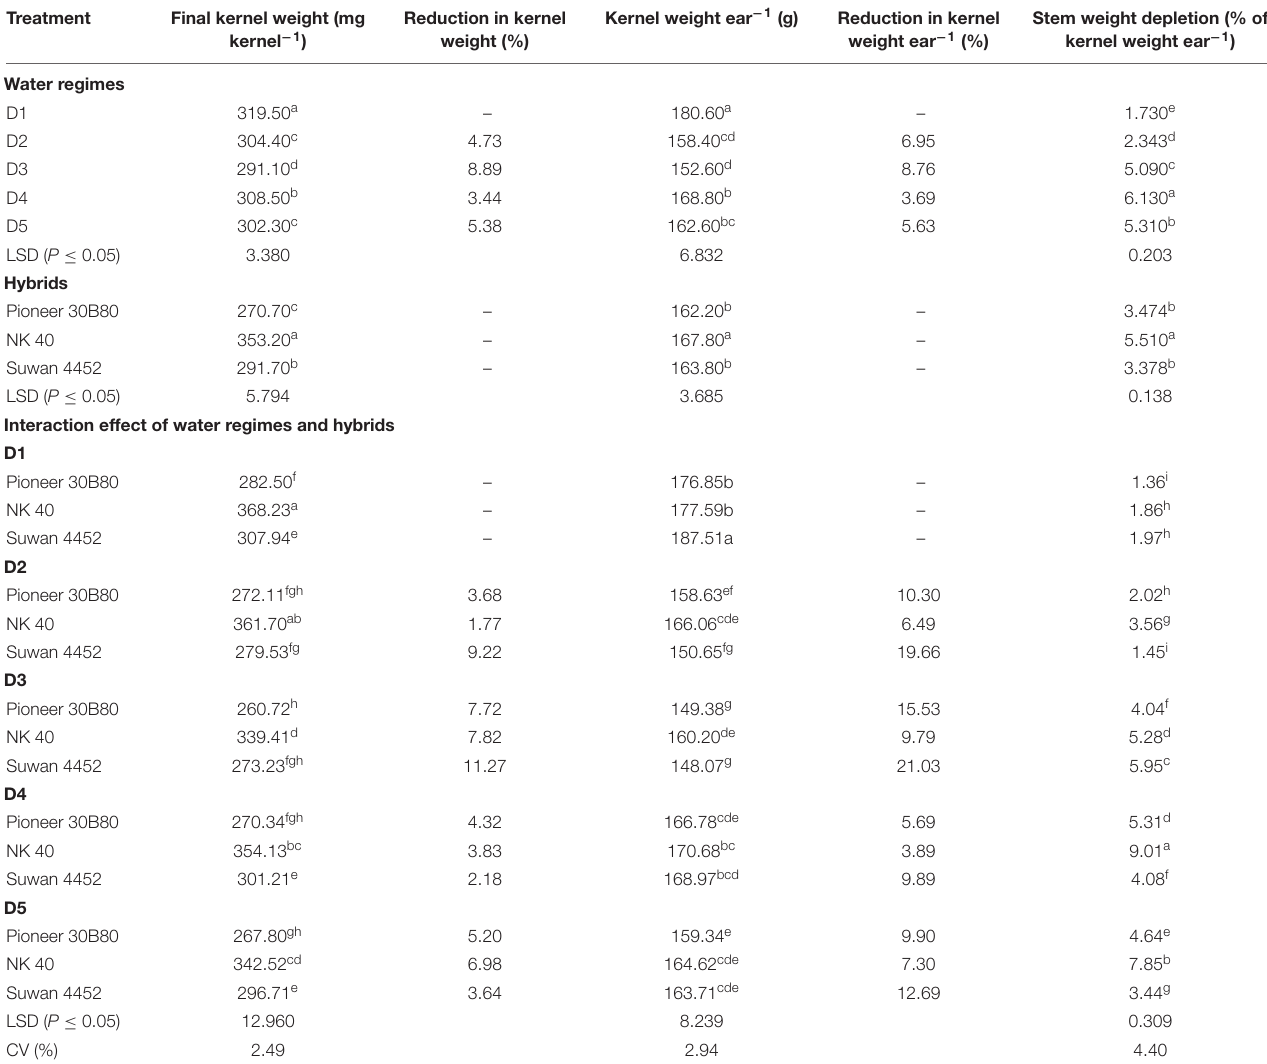
TABLE 4 | The effect of water regimes and hybrids on final kernel weight, kernel weight reduction, kernel weight ear − 1 , reduction in kernel weight ear − 1 , and stem weight depletion (% of kernel weight ear − 1 ) in Expt. 1.